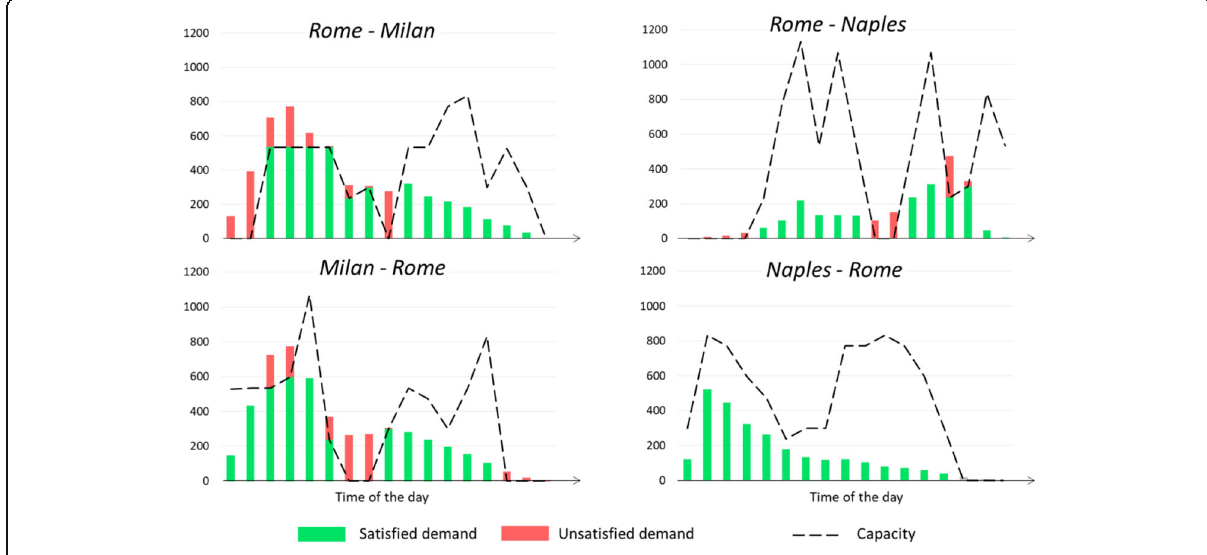
Fig. 8 Estimated demand flows by hour-of -day in “ SCENARIO 40% ”